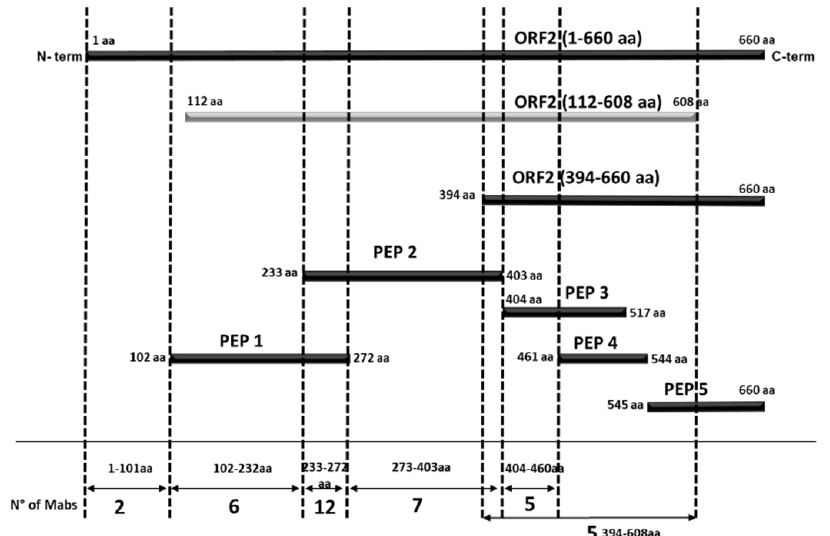
Figure 4. Schematic representation of the ORF2 recombinant proteins/peptides produced. The numbers of MAbs that recognize various portions of ORF2 are presented at the bottom of the diagram. The proteins expressed in E. coli are highlighted in black, while the ORF2 (112–608 aa) expressed in baculovirus is highlighted in light grey.